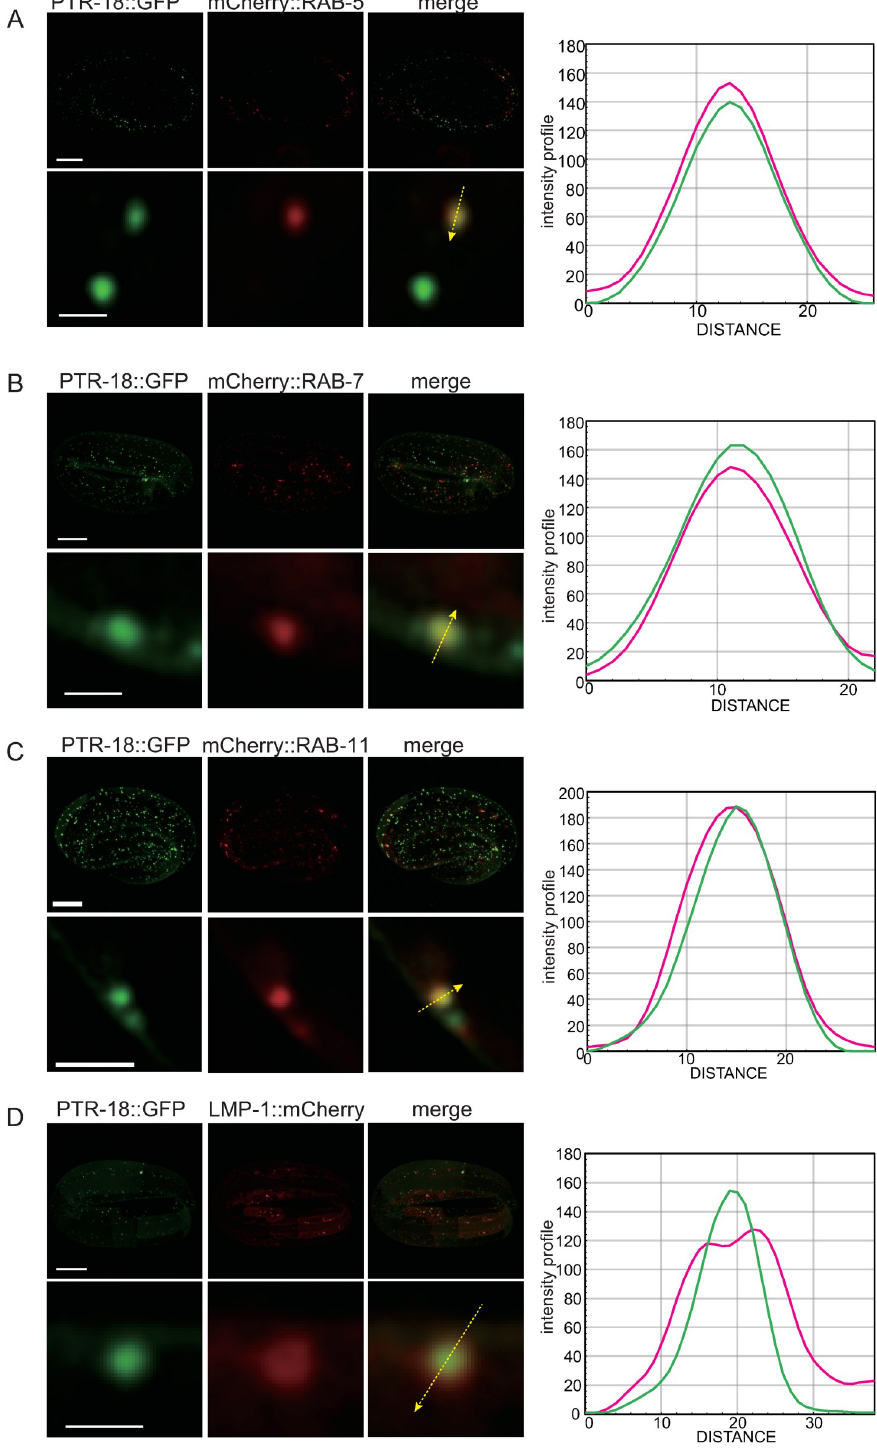
Fig 4. PTR-18::GFP localized to endosomes and lysosomes. Super-resolution images showing expression patterns of PTR-18::GFP and markers for endosomes and lysosomes. (A–D) Images on top rows show the maximum intensity Z projection of an entire embryo expressing indicated reporters, and scale bars indicate 10 μ m. Images in the bottom rows show a magnified view of a Z section selected from the Z stacks of the above row, and scale bars indicate 1 μ m (A, B, and D) or 2 μ m (C). Intensity profiles along the arrow in each of the magnified image are shown on the right.